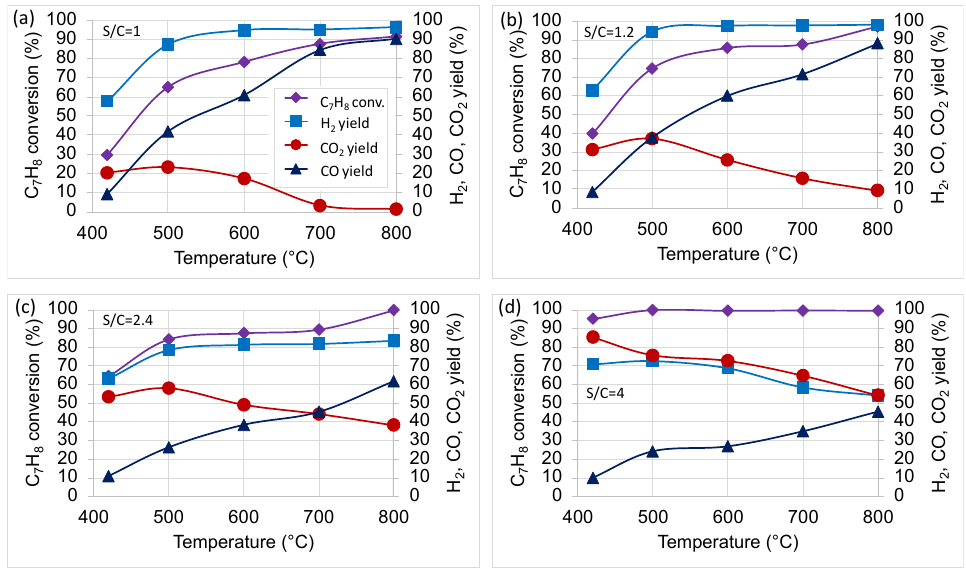
Figure 1. The evolution of C 7 H 8 conversion and CO, CO 2 , and H 2 yields during catalytic runs of SRT carried out on Ni/CeZrO 2 at t c = 0.36 s and under the S/C ratio of 1 ( a ), 1.2 ( b ), 2.4 ( c ), and 4 ( d ). Time-on-stream at each temperature was 24 h.